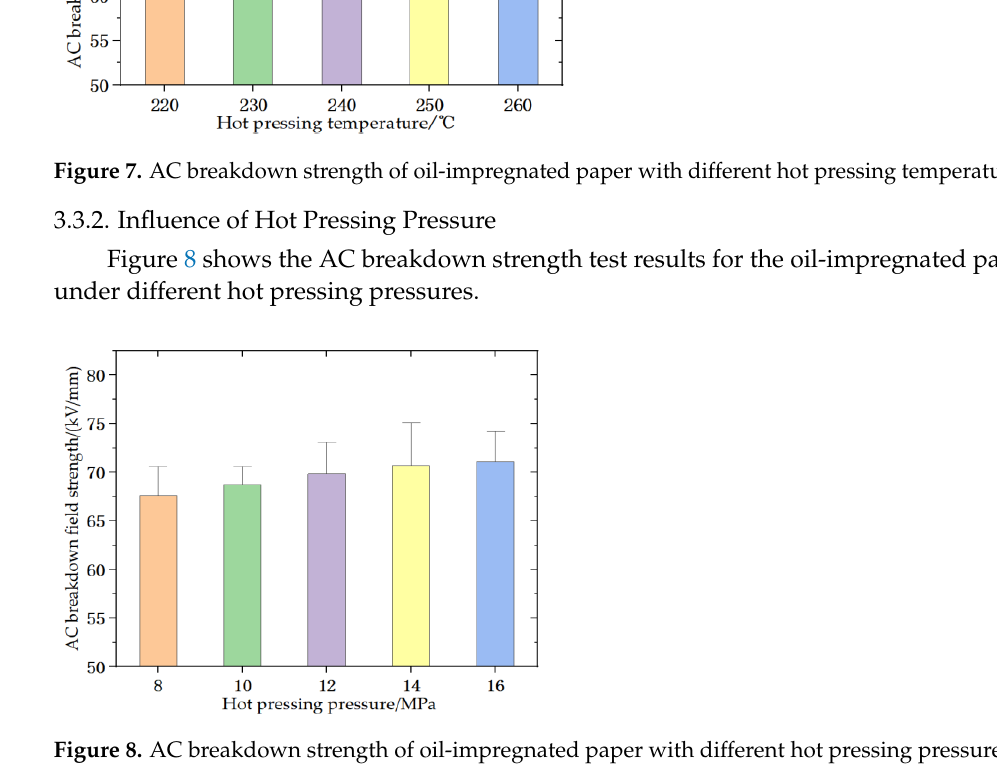
Figure 8. AC breakdown strength of oil-impregnated paper with different hot pressing pressures.